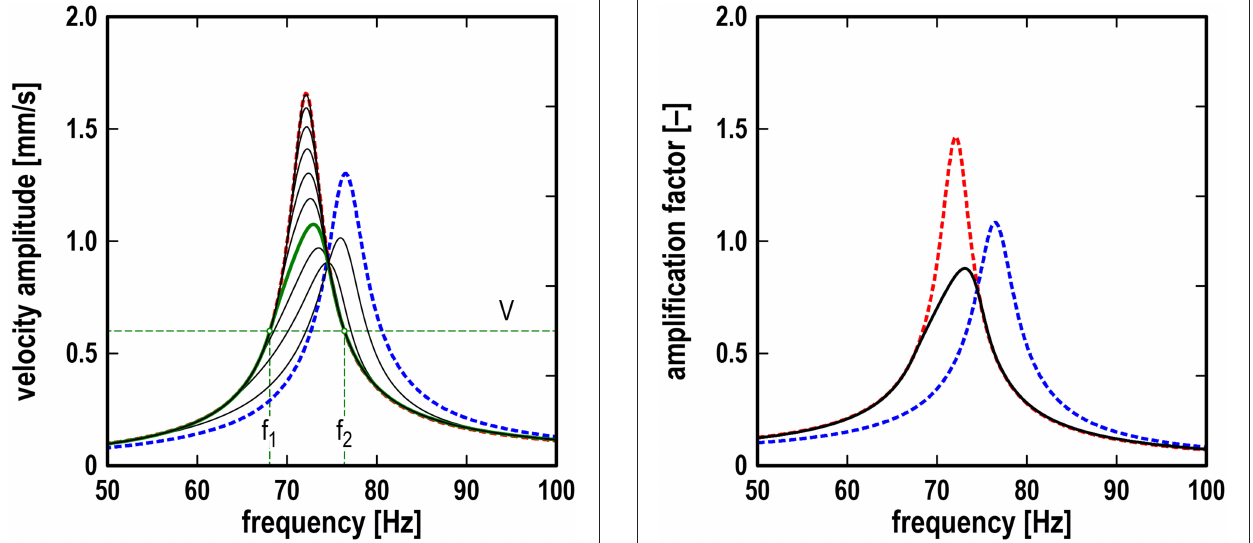
FIGURE 2 | Dependencies of velocity amplitude of rigid arm on excitation frequency for different rubber roller velocities; blue broken line: case II (static contact); red broken line: case III (fully slipping contact). Decrease of sliding velocity (starting from the complete sliding – left high peak) leads first to a decrease of the resonant peak (with practically unchanged resonant frequency) followed by a relatively quick shift of the frequency toward the value corresponding to the stationary contact. For each particular sliding velocity V the curve under the horizontal line at the level of sliding velocity (between frequencies f 1 and f 2 ) remains unchanged compared to the case of complete sliding.